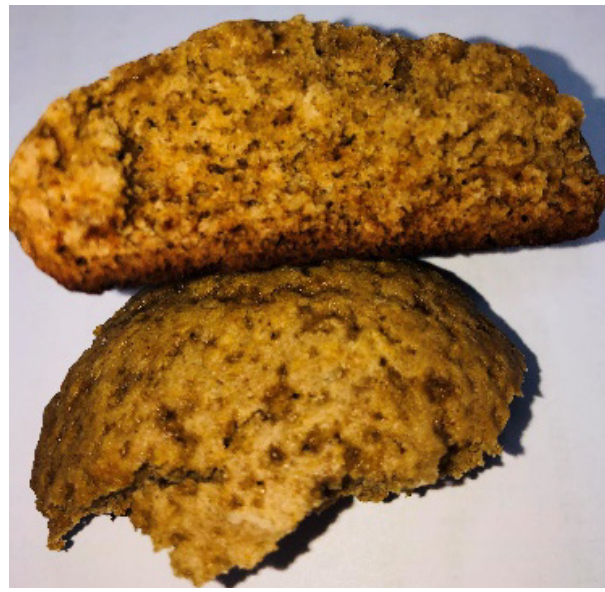
Figure 3. Spent grain